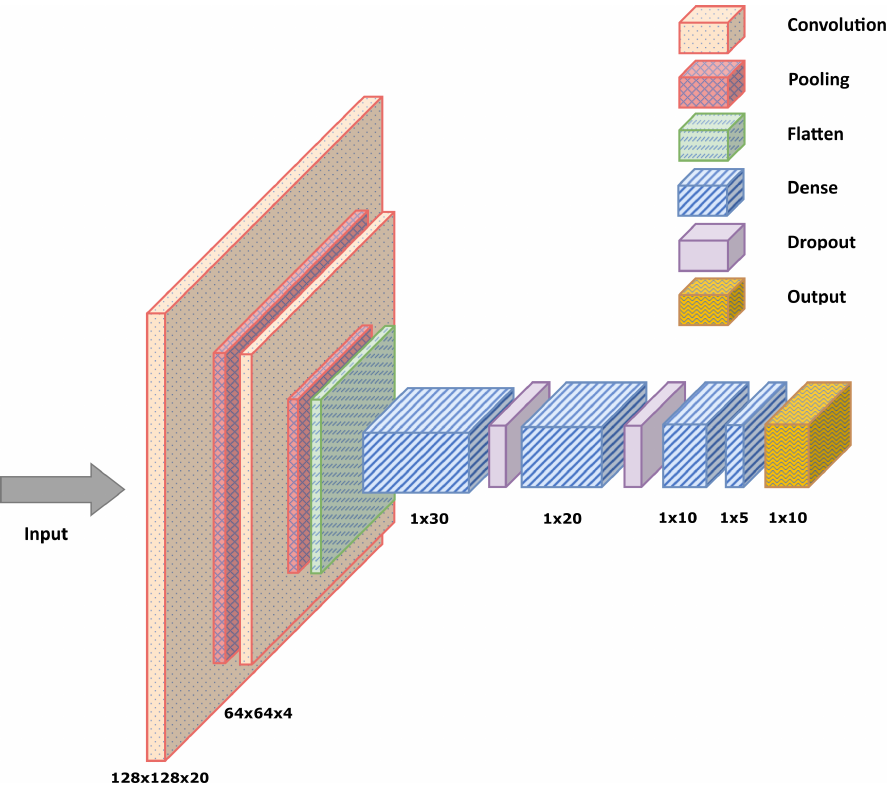
Figure 5. DCNN Neural